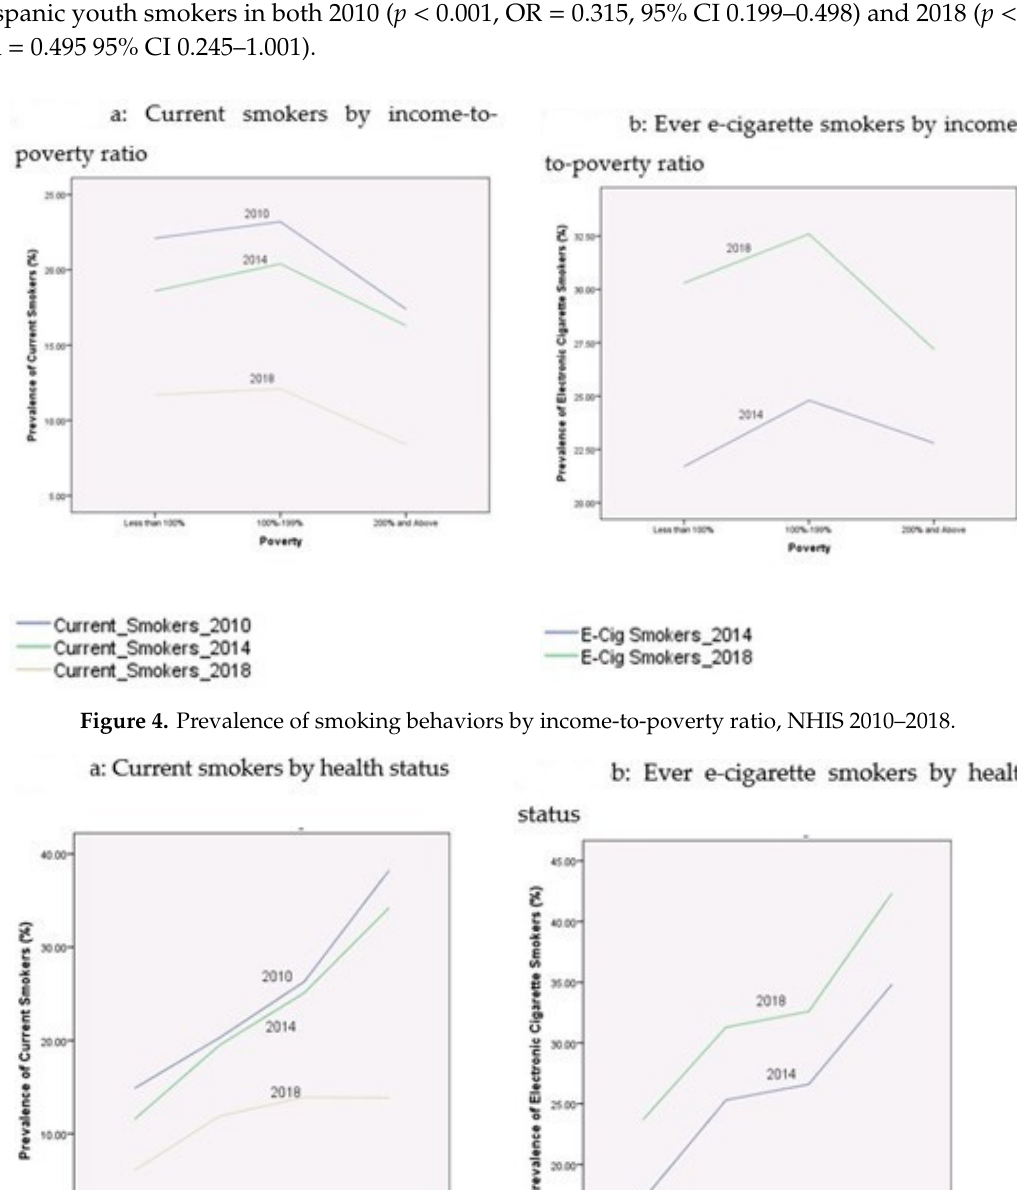
Figure 3. Prevalence of smoking behaviors by education, NHIS 2010–2018.